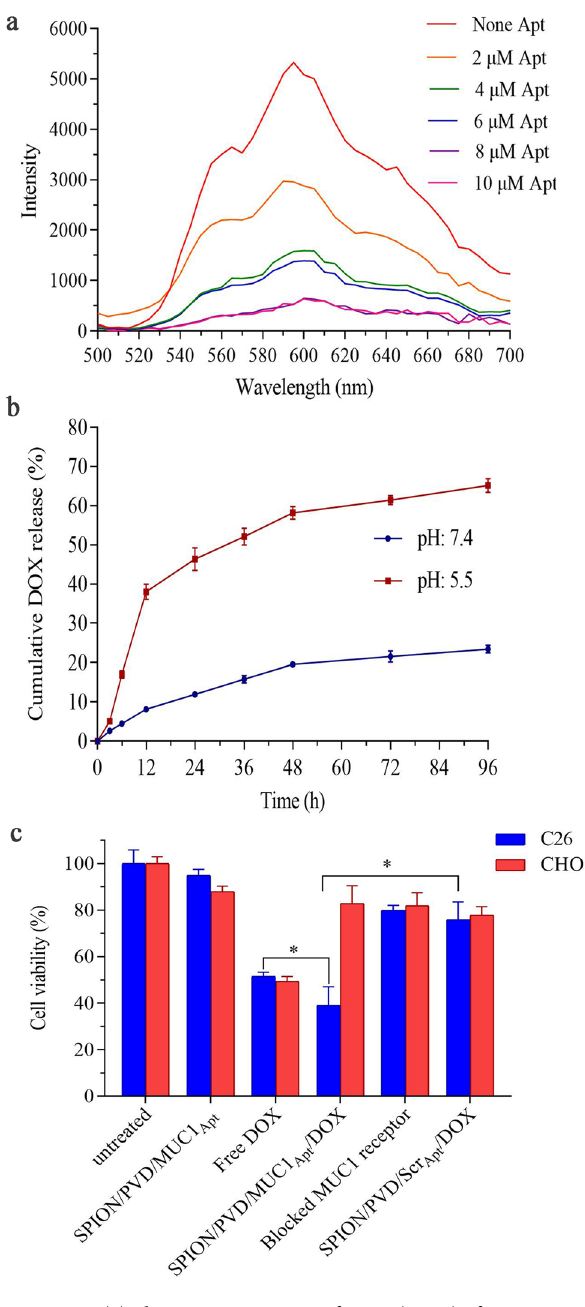
Figure 4. ( a ) Fluorescence spectra of DOX (2 µM) after treatment with increasing concentrations of SPION/ PVD/MUC1 Apt complex (based on aptamer concentration 0, 2, 4, 6, 8, and 10 µM); ( b ) In vitro DOX release profile of SPION/PVD/MUC1 Apt /DOX in citrate buffer (pH 5.5) and PBS (pH 7.4) at 37 °C; ( c ) Cell viability assessments of free DOX, SPION/PVD/MUC1 Apt , SPION/PVD/MUC1 Apt /DOX and SPION/PVD/Scr Apt /DOX in C26 and CHO cell lines after 48 h of incubation at 37 °C. Data are shown as mean ± SD (n = 3). Statistical analysis was performed using GraphPad Prism Version 8.0 (https:// www. graph pad.